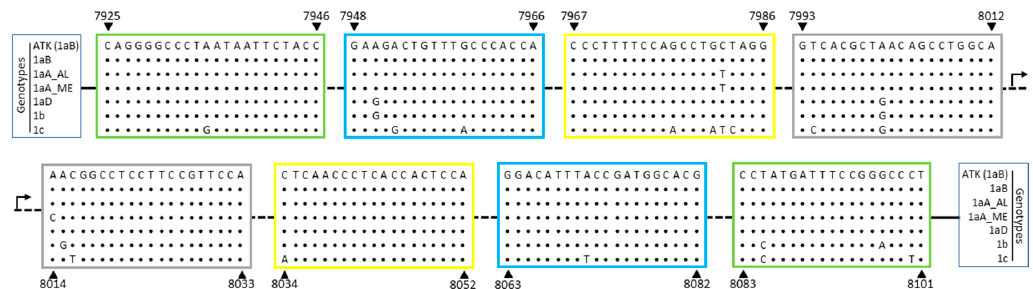
Figure 1. HTLV-1 tax sequence recognized by LAMP primers. HTLV-1 genome sequence corresponding to LAMP primers designed based on the ATK strain (GenBank J02029, which belongs in Table 1; aB), were aligned with representative sequences from other HTLV-1 genotypes: 1aA_LA, Cosmopolitan Transcontinental, Latin American cluster; 1aA_ME, Cosmopolitan Transcontinental, Middle East cluster; 1aD, North Africa; 1b, Africa; and 1c, Melanesia. The nucleotide positions are related to the ATK strain (indicated by arrows) and the regions for primer hybridization are highlighted in boxes: green: F3/B3; blue: F2/B2; yellow: LF/LB; gray: F1c/B1c.